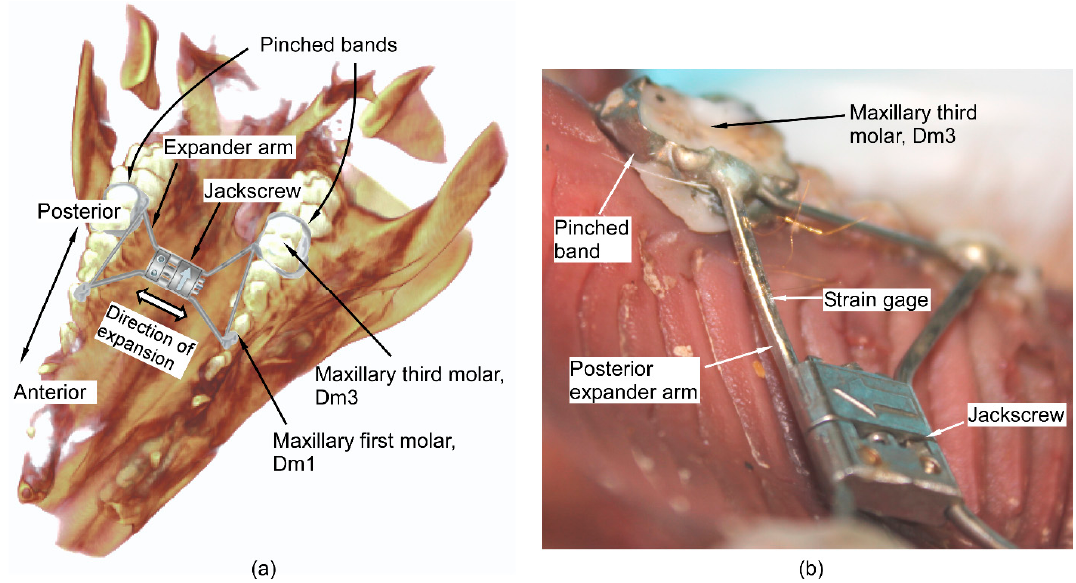
Figure 1. ( a ) Illustration of the hyrax-design RPE and the attachment of the expander arms superimposed on the maxillofacial structures of the pig head. ( b ) Location of the strain sensor attached to the posterior expander arm, prior to the use of dental composite.